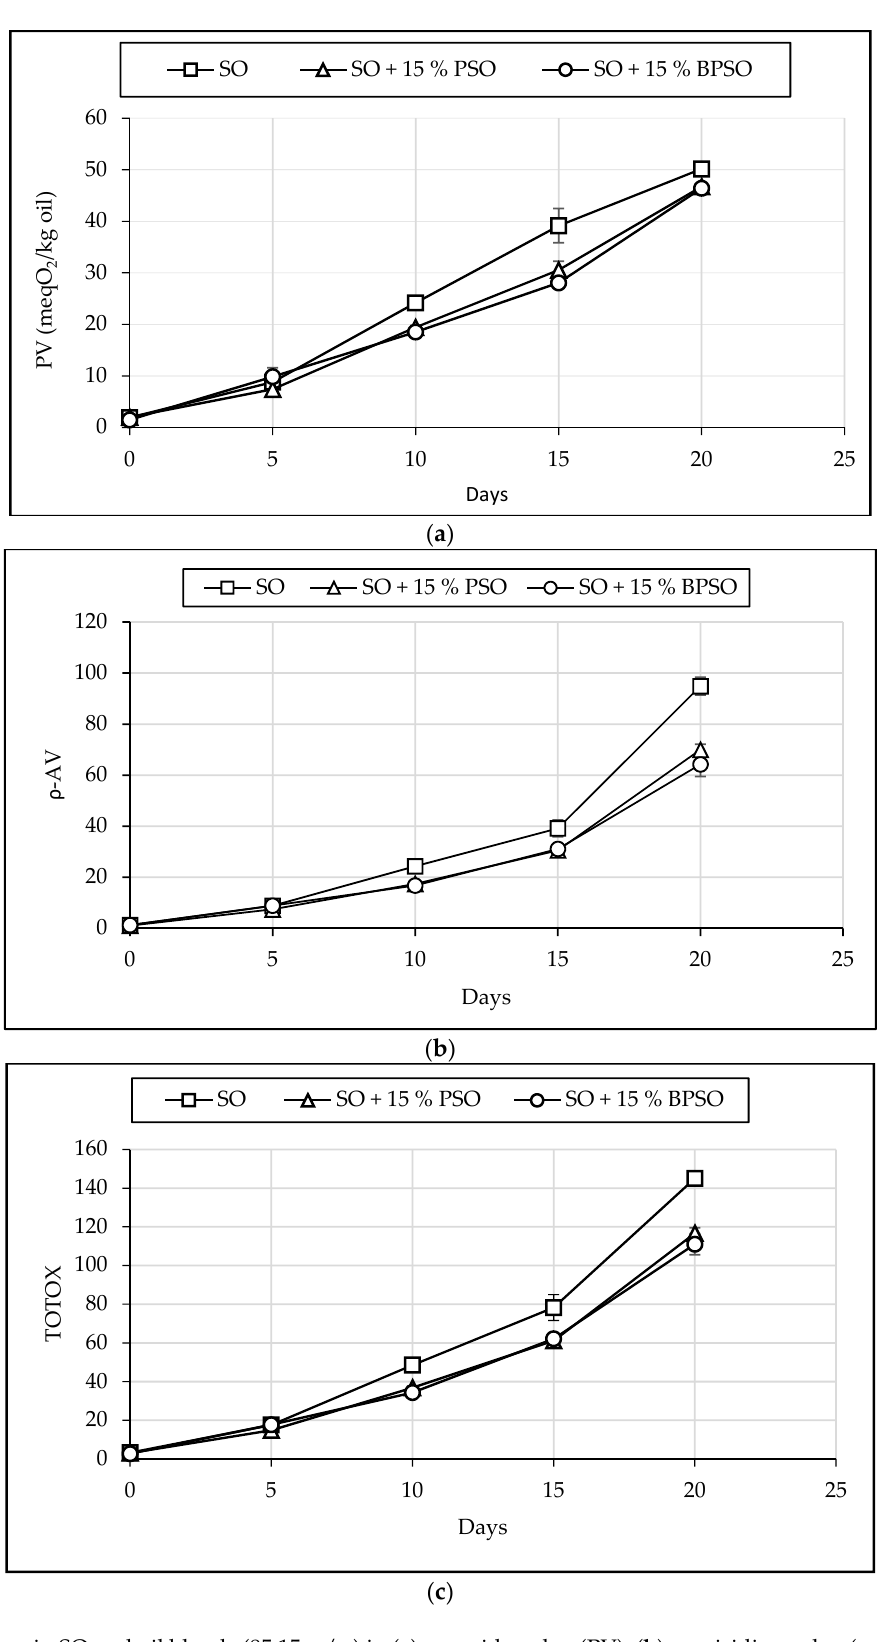
Figure 1. Changes in SO and oil blends (85:15 w / w ) in ( a ) peroxide value (PV), ( b ) ρ -anisidine value ( ρ -AV), and ( c ) total oxidation value (TOTOX) during accelerated storage. Values given are the mean of three replicates. SO—sunflower oil, PSO—pomegranate seed oil from unblanched seeds, BPSO—pomegranate seed oil from blanched seeds.